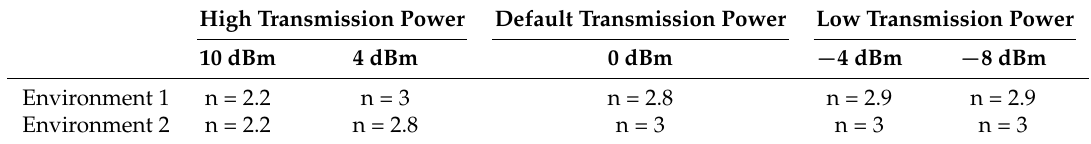
Table 4. Path loss exponent in two different indoor